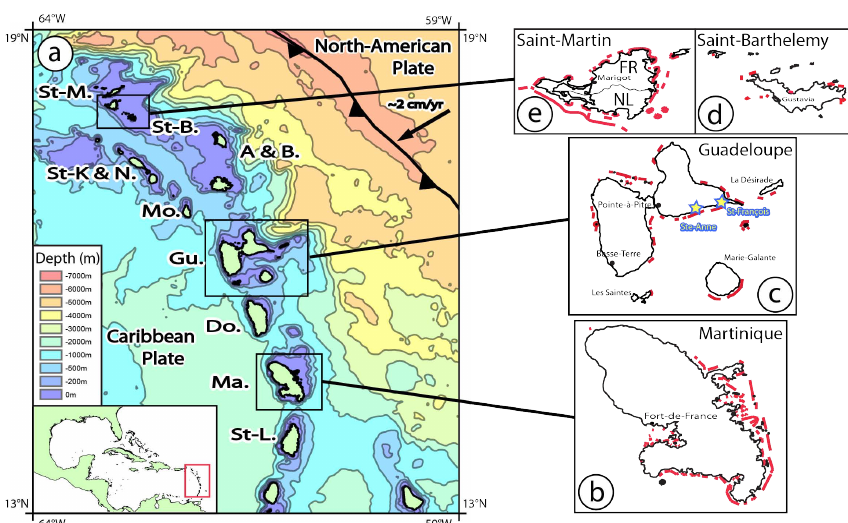
Fig. 1. (a) Location of the French Islands within the Lesser Antilles Arc; Ma.: Martinique; Gu.: Guadeloupe; St-M.: Saint-Martin; St-B.: Saint-Barthelemy; an approximate convergence rate of ∼ 2cmyr − 1 from DeMets et al. (2007) is indicated as well as the subduction trench between the North American and Caribbean tectonic plates; inset locates the Lesser Antilles Arc in the Caribbean region with a red rectangle. (b) , (c) , (d) , (e) Repartition of the fringing coral reefs (red lines) surrounding the French Caribbean Islands. Saint-Franc¸ois and Sainte-Anne (Guadeloupe) are indicated with yellow and blue stars (c) .